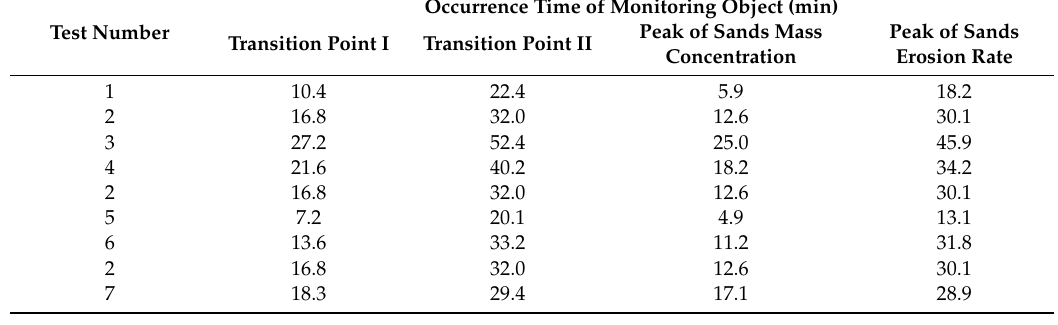
Figure 9. Variation curve of monitoring objects with relative density ( D r ). ( a ) Variation of water- outflow rate with relative density; ( b ) Variation of sands erosion rate with relative density; ( c ) Variation of sands mass concentration with relative density. Table 7. Variation of monitoring objects’ characteristic value with relative density ( D r ).